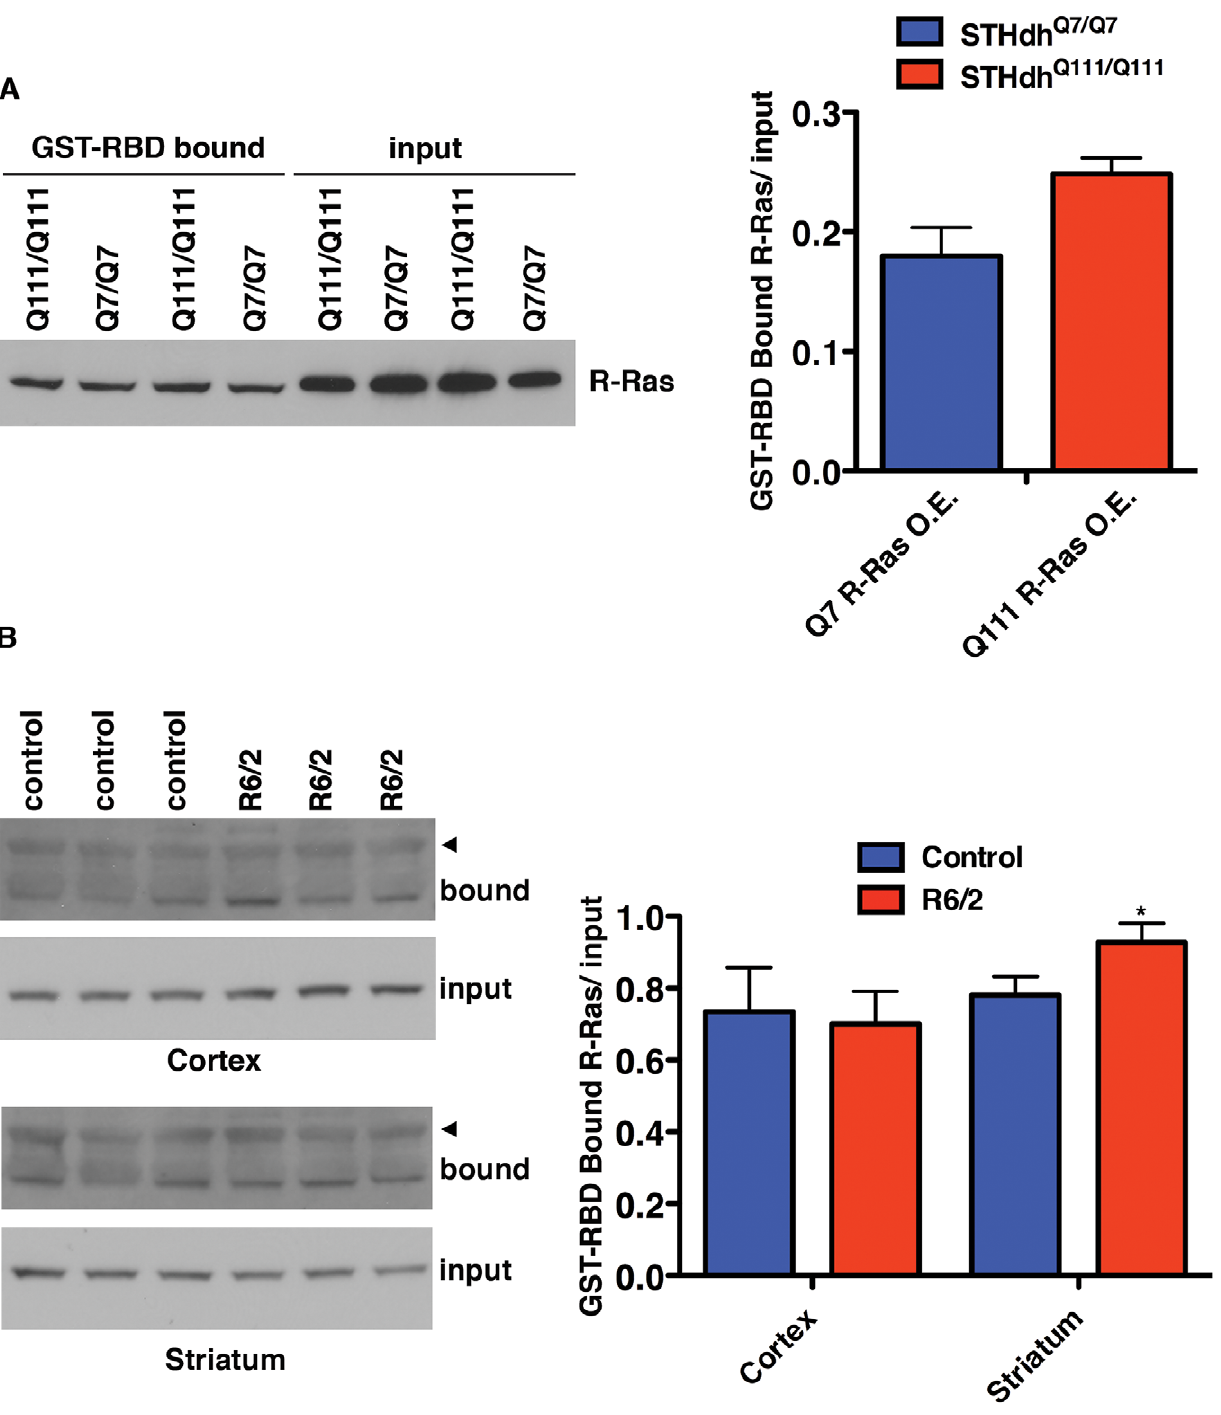
Figure 7. Levels of Active R-Ras Are Elevated in HD Models. (A) ST Hdh cells overexpressing R-Ras were subjected to GST-RBD pull-downs to detect the amount of GTP-bound R-Ras (n=2). (B) The R6/2 mouse model of HD has increased GTP-bound R-Ras in the striatum (n=3). The arrowheads indicate a higher molecular mass band of unknown origin that is only present in the pull-down samples. *p , 0.05, Student’s t-test.